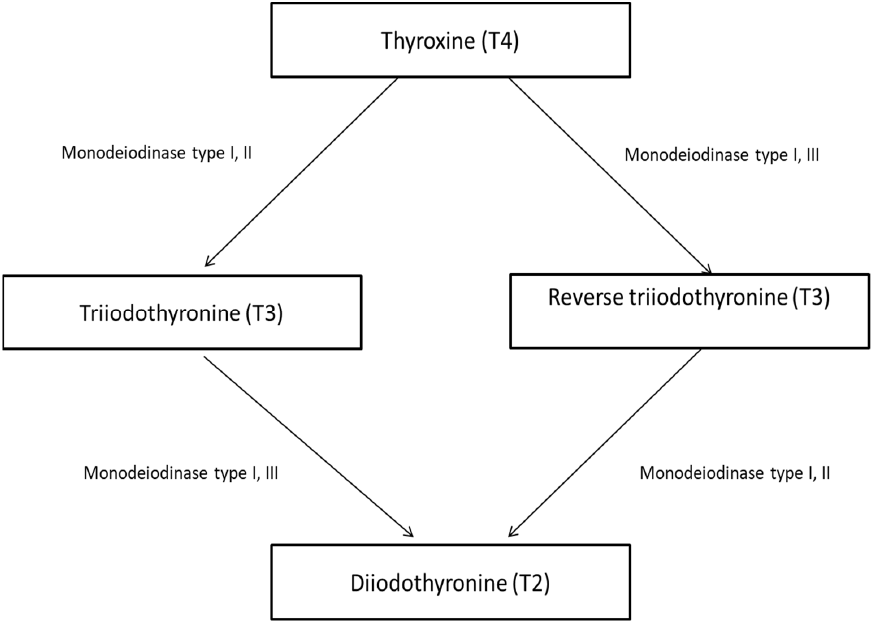
Figure 1. Thyroid deiodinases.